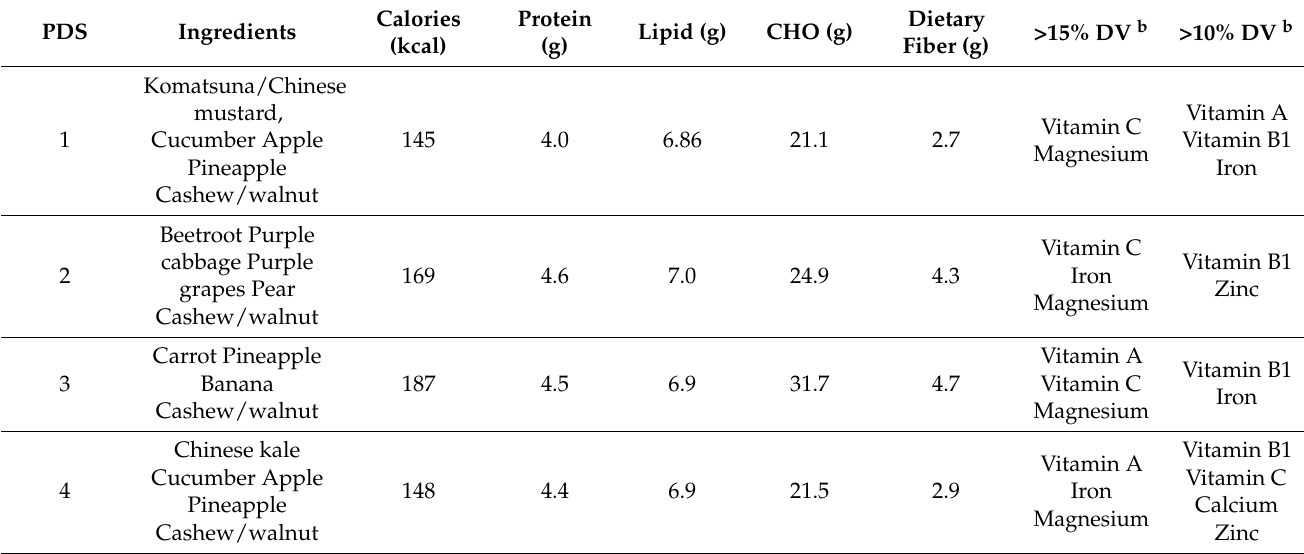
Table A1. Nutrition contents of four PDS a .